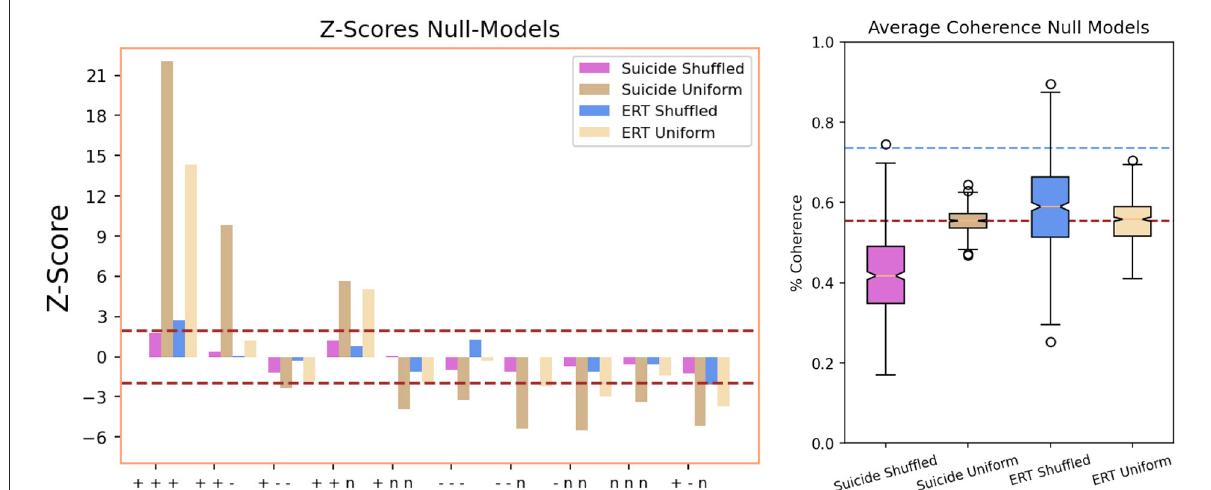
FIGURE3 (Left) Z-scores indicating the occurrence of signed triangles in the empirical emotional networks for suicide notes and ERT recalls against 2 random null models (Shuffled and Uniform). (Right) Boxplot comparing the distribution of observed emotional coherence in the null models against the value observed in the emotional network of suicide notes (dashed lines, the lower one is relative to suicide notes, the upper one to healthy ERT